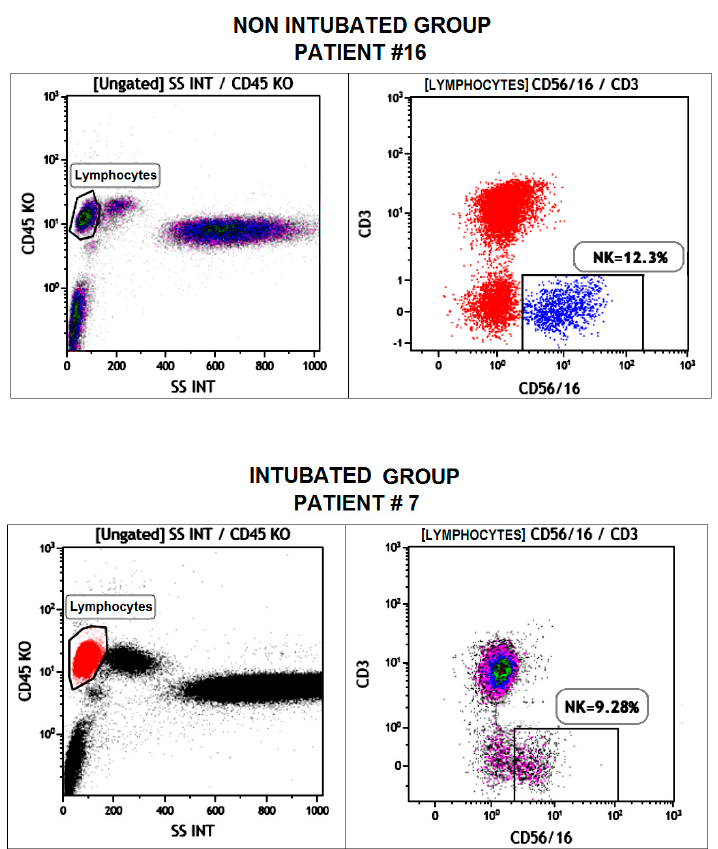
Figure 2. Dot-plot flow cytometry photos from samples withdrawn after 7 days post-operation in two different and representative patients belonging to the non-intubated ( top ) and intubated ( bottom ) groups and demonstrating the higher level of natural killer cells in the non-intubated patient.